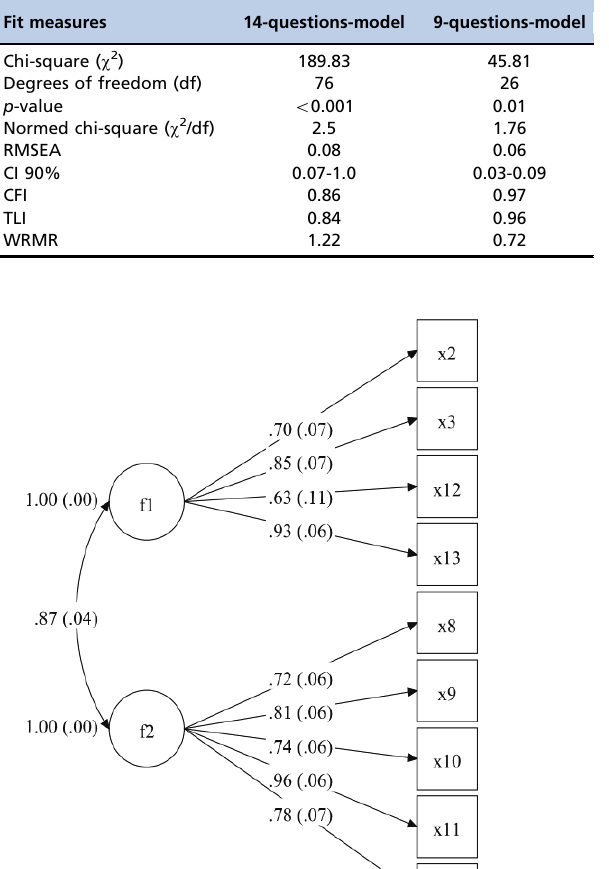
Table 4 - Comparison of CFA-SEM between the hypothetical model and the well-fit model. Fit